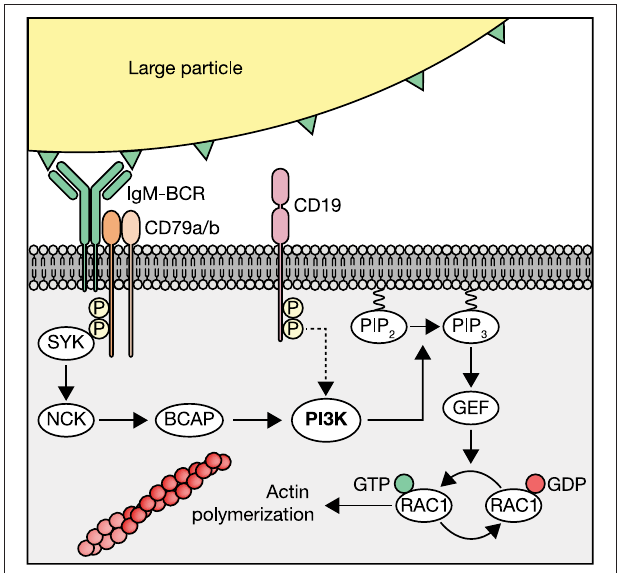
FIGURE 6 | Schematic of IgM-BCR-induced PI3K-driven internalization of large particles. Human B cells internalize large particles though IgM-BCR activation of PI3K via NCK without profound requirement of the co-receptor CD19 (dotted arrow). PI3K facilitates internalization though the conversion of phosphatidylinositol 4,5-biphosphate (PIP 2 ) to phosphatidylinositol 3,4,5-triphosphate (PIP 3 ) to recruit guanine nucleotide exchange factors (GEFs) that modulate RAC1-dependent activation of the actin